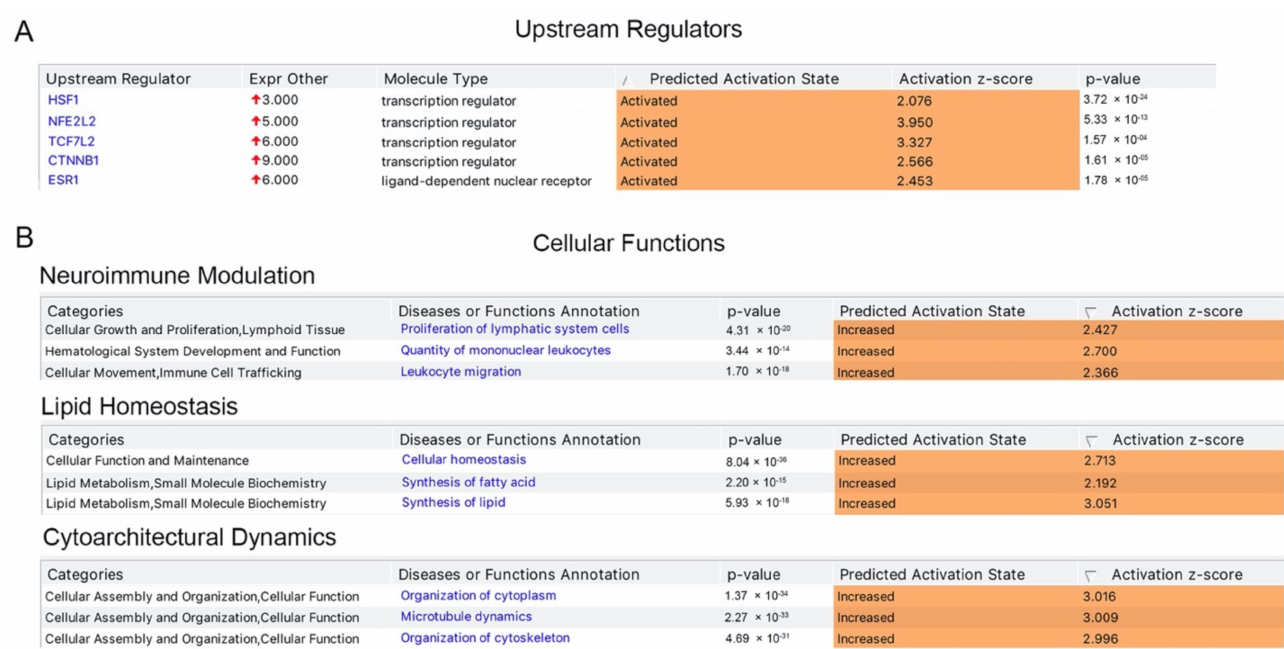
Figure 2. Upstream regulators and cellular functions associated with HSP and PLS. ( A ). Key upstream regulators, which are suggested to be activated in upper motor neurons. ( B ) Key cellular functions that are suggested to be active in upper motor neurons. Canonical pathways that are related to neuroimmune modulation, lipid homeostasis and cytoarchitectural dynamics are suggested to be activated with significance that cannot be explained by